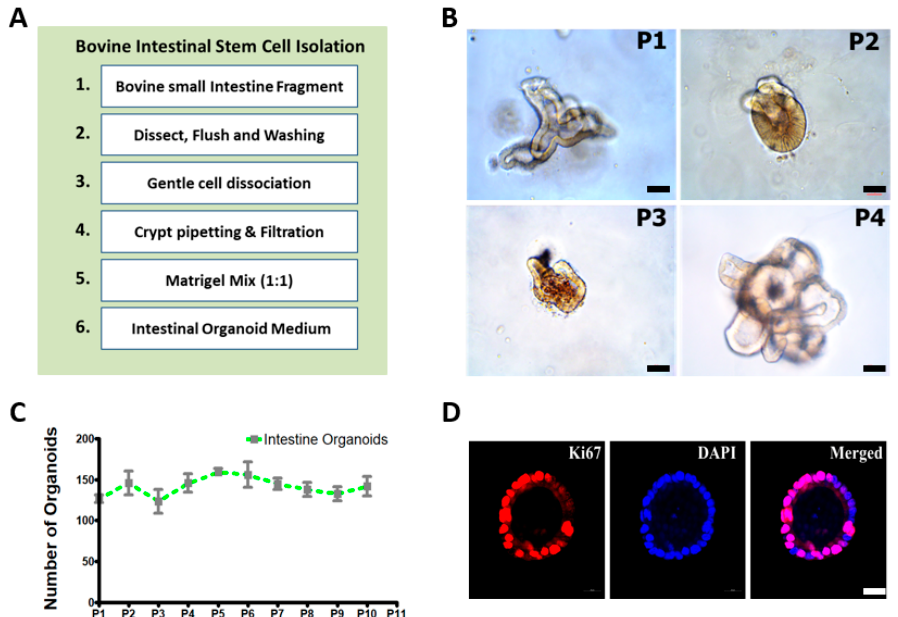
Figure 1. Isolation of intestinal crypts and three-dimensional (3D) cultivation of intestinal crypts including intestinal stem cells in bovine: ( A ) experimental procedures regarding the isolation of intestinal crypts from the small intestine and the three-dimensional (3D) cultivation of intestinal crypts including intestinal stem cells in bovine; ( B ) robust 3D expansion of intestinal crypts including bovine intestinal stem cells (P1–P4). The organoids can be spheroidal (round shaped), show budding (spheroids with extension), and have mature villi and crypt-like structures (branched structures). Scale bar: 50 µ m; ( C ) growth rate graph of bovine intestinal organoids showing the number of organoids/well (mean n = 3 wells) growing in a 100 µ L Matrigel dome in each well. Intestinal organoids were maintained for up to 10 generations without loss of the recapitulating capacity of crypts; ( D ) intestinal organoids were immunostained for Ki67 at passage 5, a marker of proliferating cells, and were counterstained with diamidino-2-phenylindole (DAPI). Scale bar: 20 μ m.